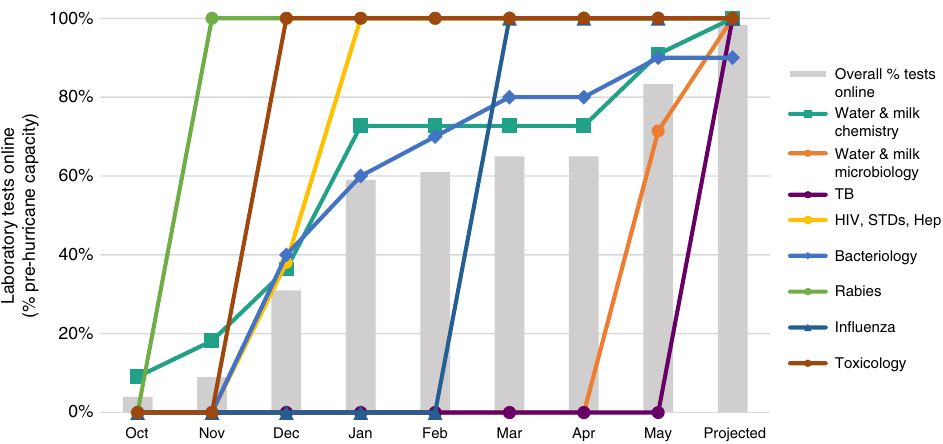
Fig. 5 PRDH laboratory testing capacity as of 18 May 2018. Capacity is presented as a percent of the actual volume of tests typically conducted by each laboratory in the previous year (2016). By this date 92% of the tests by volume were operational; by the number of tests offered before Hurricane Maria, 98% of the total testing capacity was reestablished. The “ Projected Capacity* ” column indicates the adjusted laboratory testing status after pending repairs were